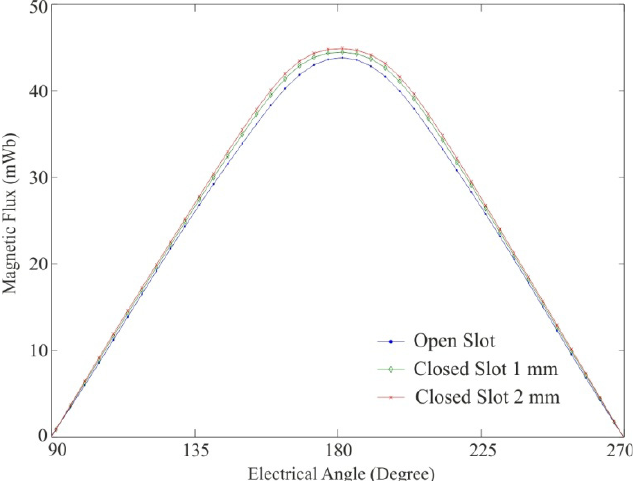
Figure 7. Total flux entering the stator linking one slot for: open slot (dot); closed slot 1 mm (diamond); and closed slot 2 mm (cross), simulated over 180 electrical degrees.